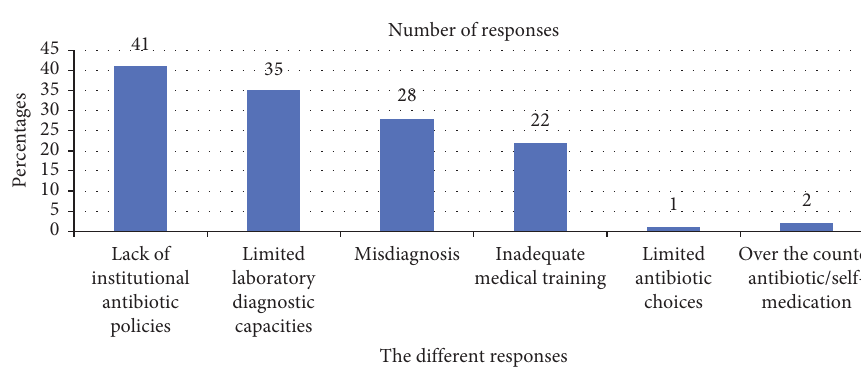
Figure 2: Assessment of possible causes of misuse.